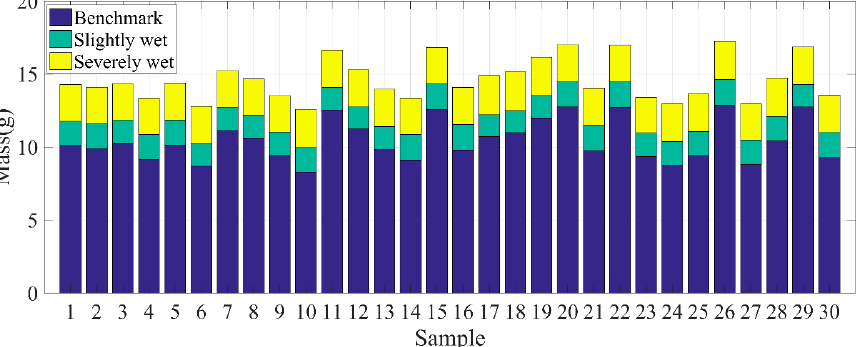
Figure 10. The mass changes of all Jilin benchmark samples after 5 and 30 min of humidification. The average spectral reflectance and corresponding three forms of spectral transforma- tions of JL samples in different soil moisture control experiments are presented in Figure 11a–d (the corresponding results of all samples are shown in Supplementary Figures S11–S14). Figures 11a and S11 show a common decrease in spectral reflectance with increasing moisture content [21,22,48]. In contrast, the spectral absorbance showed a tendency to increase with the soil moisture increase (Figures 11c and S11). Moreover, it can be seen that the water absorption range in the SWIR domain was enhanced with the increase in soil moisture in the results of R, A and C spectra (Figures 11a,c,d, S11, S13 and S14) [49–51]. The variations were not distinguished in R’